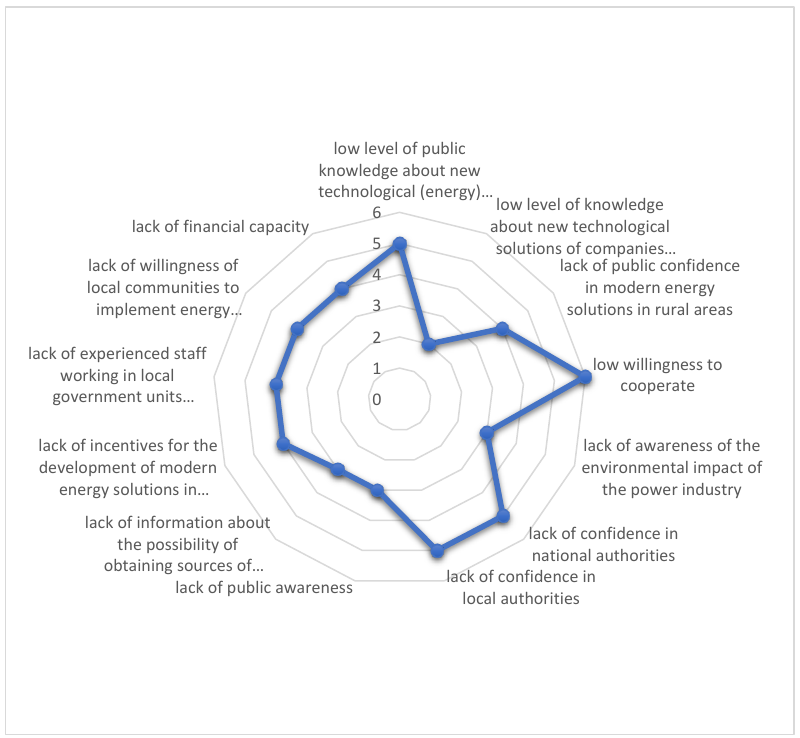
Figure 1. Importance of obstacles to the development of energy solutions in rural areas as assessed by experts. Source: own elaboration.